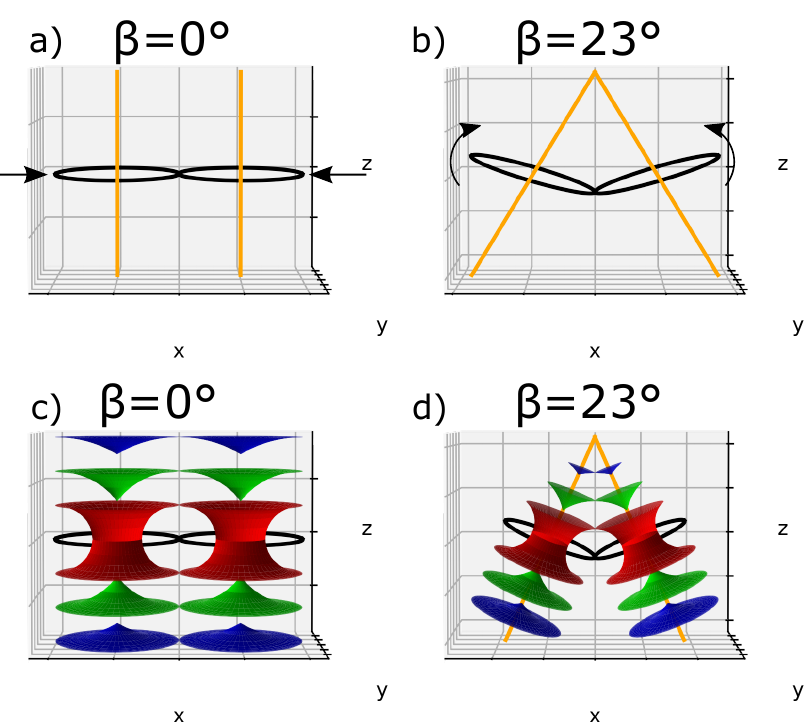
Figure 8. ( a ) The flatten case of two TFCDs whose circles are mutually tangent according to Friedel’s law (l.c.c.) with their respective parallel straight lines, ( b ) The tilted case of the same TFCDs with a random angle of inclination β = 23°, where the straight lines are converging at the top, ( c , d ) three equidistantly smectic layers attributed, respectively, to the flatten and the titled cases of